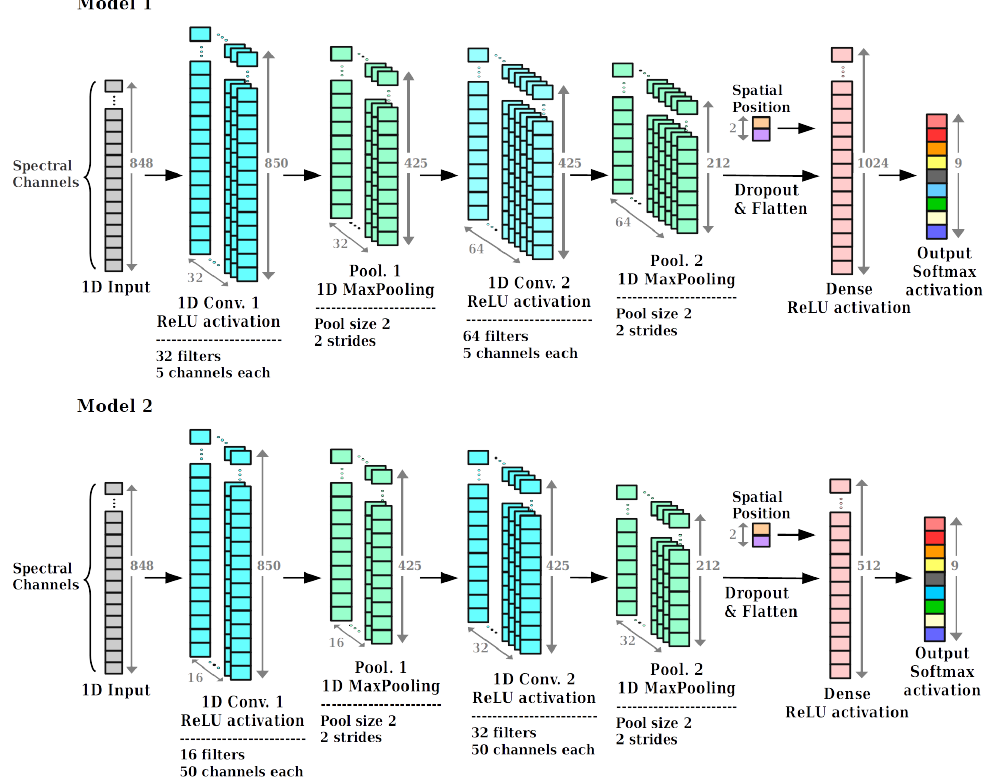
Figure 4. Architecture of CNN Model 1 ( top ) and Model 2 ( bottom ) used for the classification and segmentation of the hyperspectral data shown in Figure 1 and trained on the hand-labeled examples shown in Figure 3. The two models differ only in the size and number of convolutional